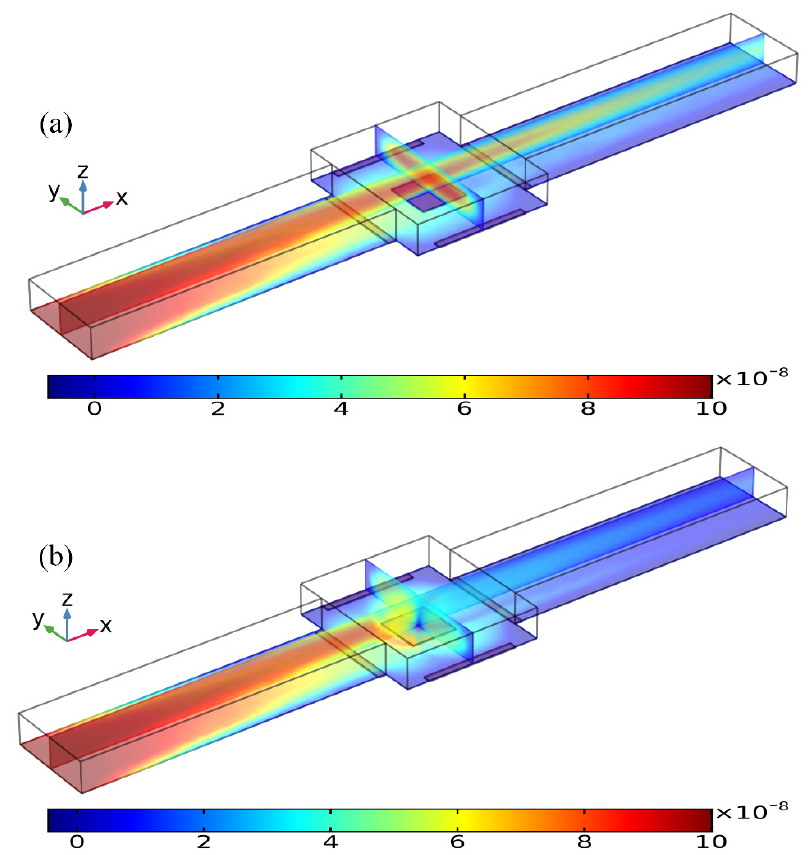
Figure 10. Concentration distribution of the incoming antigen injected from the inlet of a straight fluidic channel at t = 80 s, which is modified by the ROT-ICEO vortex flow field on the top of the square FE of 300 μ m in edge length inside the central microchamber, when the peripheral DE array was excited by TW voltage signals of ( a ) V 0 = 0 V, and ( b ) V 0 = 8 V at f = 200 Hz with an average inlet flow rate of 50 um/s. (unit: mol/m 3 ).